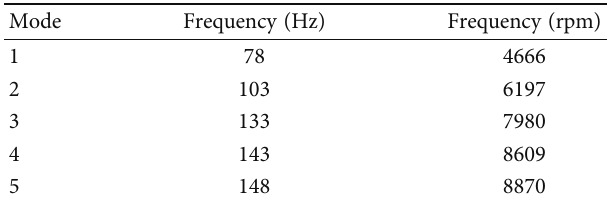
Figure 21: Total kinetic energy for the glass bottles. Table 9: List of fi rst fi ve natural